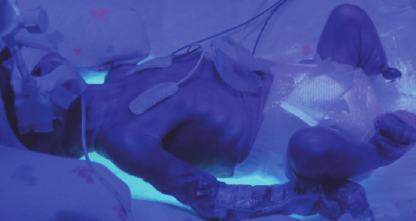
Figure 4: Under phototherapy, amputated left lower extremities are